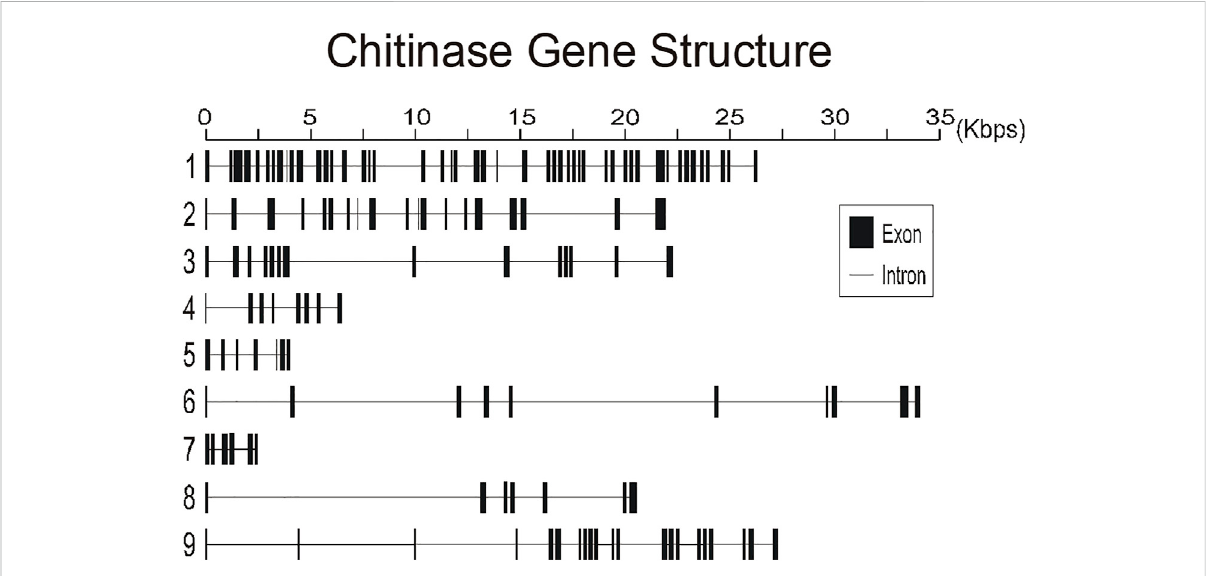
FIGURE 1 Schematic diagram of exon and intron organization of chitinase genes RpCht1-9 from R. prolixus . Black boxes: exons. Gray lines: introns. Numbers 1 – 9 represent genes RpCht1-9 ,